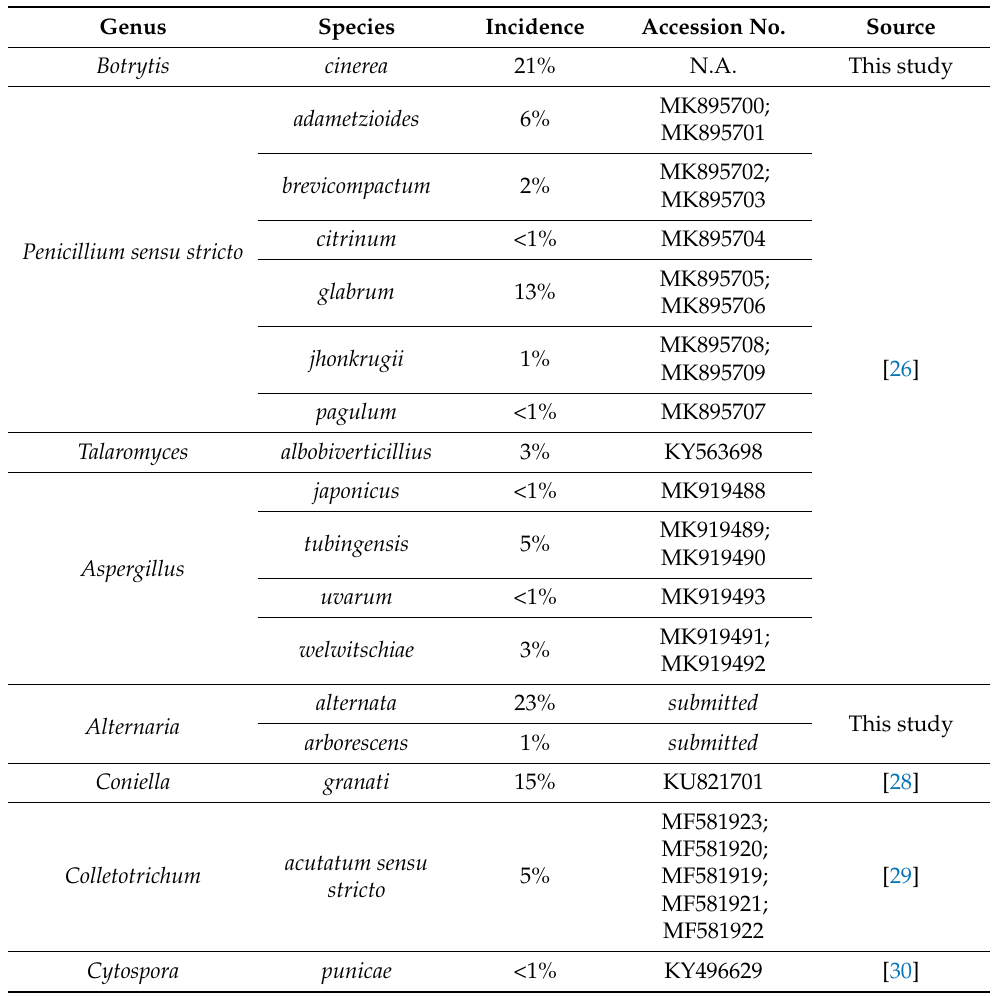
Table 2. Incidence of each recorded fungal species and accession numbers of strain sequences deposited in GenBank. “N.A”, not available. Genus Species Incidence Accession No. Source Botrytis cinerea 21% N.A. This study